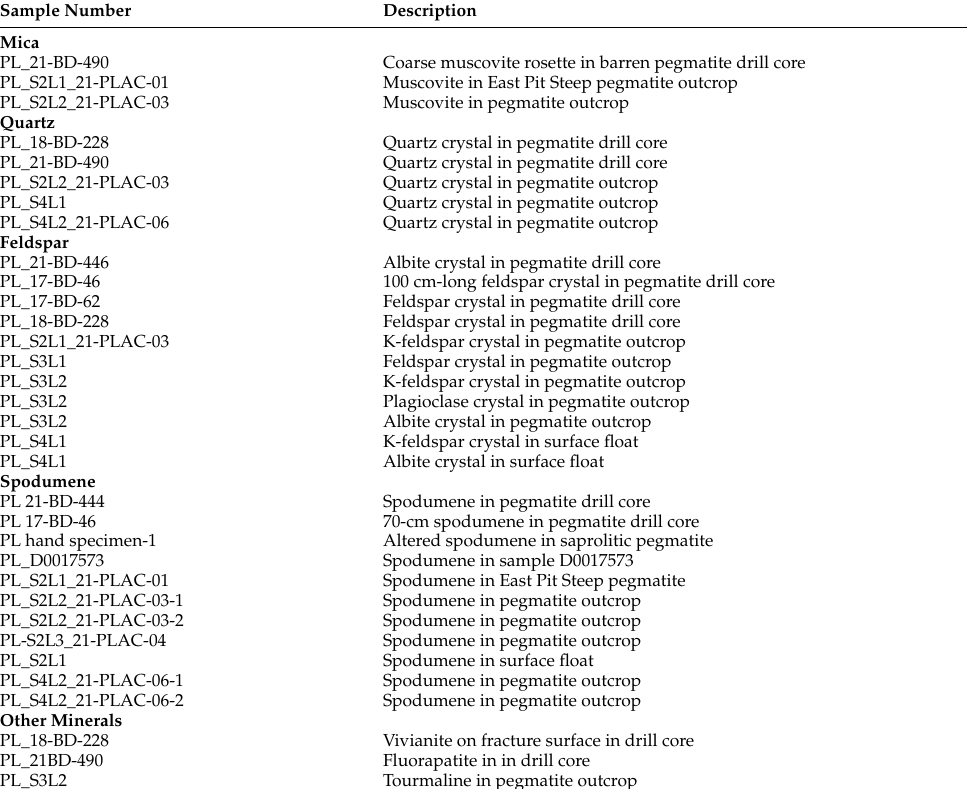
Table A1. Minerals analyzed by handheld LIBS on the Piedmont Lithium Carolina Lithium Project prospect, Gaston County, N.C.